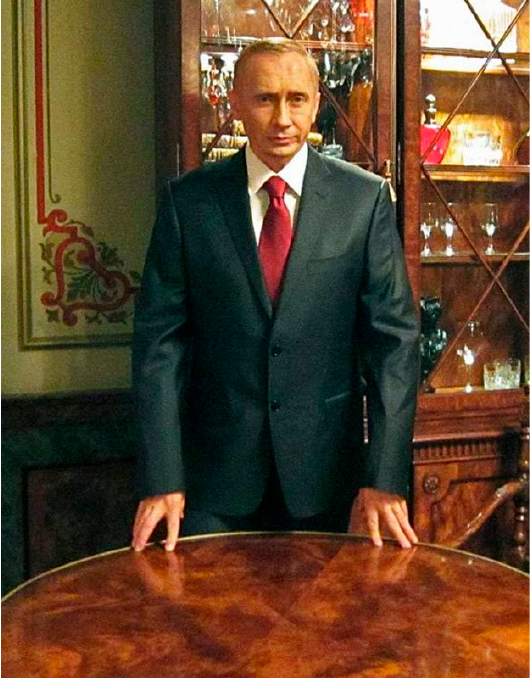
Figure 10. Vlad Mamyshev-Monroe. From the series “Remember about gas” (Pomiatai pro gaz, 2011), https://vmmf.org/series/view?id=42 (accessed on 11 September 2022).